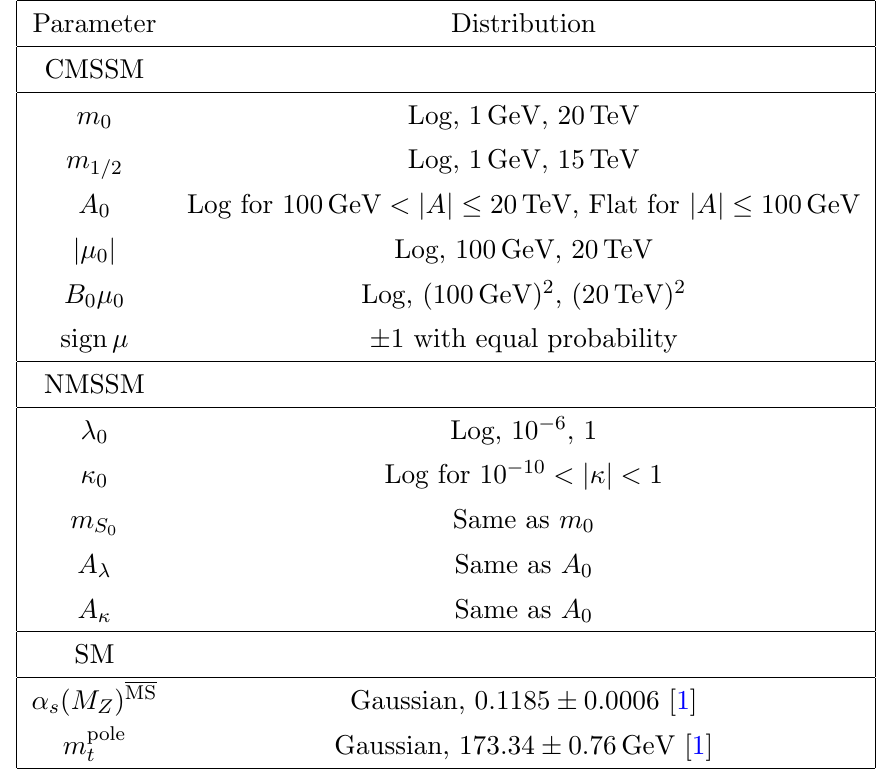
Table 2. Priors for the CMSSM and semi-constrained NMSSM model parameters. In the CMSSM, (cid:22) 0 is marginalized in accordance with M Z , while in the NMSSM m S is marginalized as j j S , as described in section 4.2.1. The full set of parameters in our scan of the CMSSM includes h i the SM parameters, and the same priors are used in the NMSSM for those parameters that are shared with the CMSSM. In the case of the NMSSM, the parameters instead we specify priors for (cid:21) 0 and (cid:20) 0